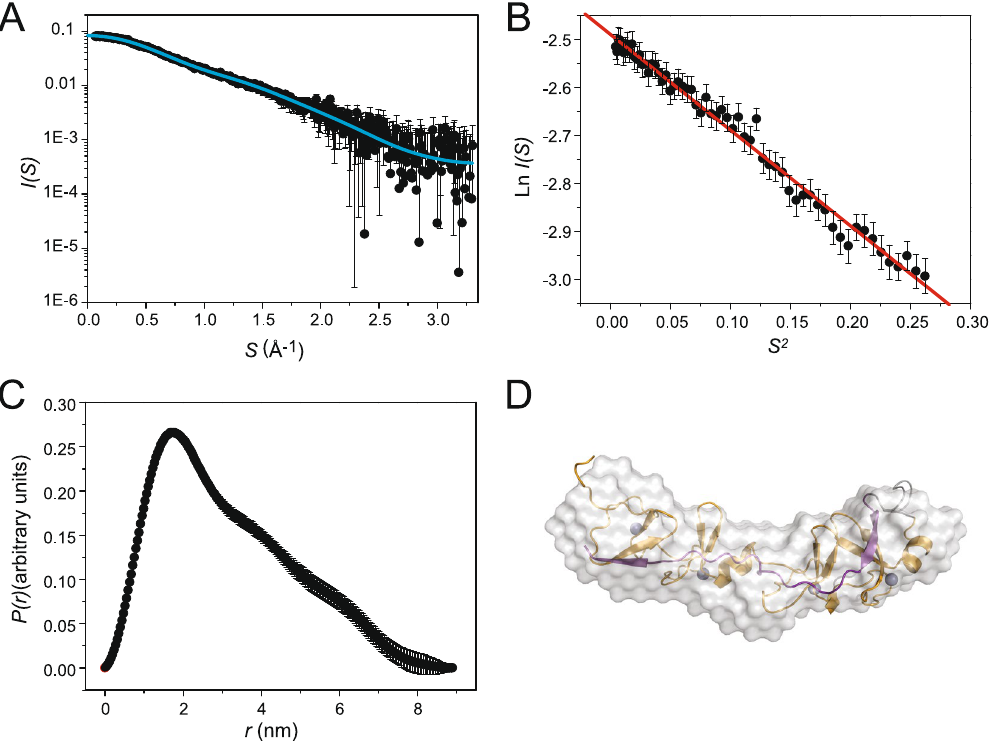
Figure 4. SAXS analysis for CEH-14–LIM-7. ( A ) Buffer-corrected, desmeared SAXS scattering curve of CEH- 14–LIM-7 (circles; 5.2 mg mL − 1 ) in 20 mM Tris pH 8.0, 150 mM NaCl, 1 mM TCEP, overlaid with the theoretical scattering profiles of an homology model of CEH-14–LIM-7 based on the template of the LHX3-ISL1 crystal structure (1RGT Chain B; cyan line) calculated by CRYSOL. ( B ) Guinier plot showing linearity of low Q data. ( C ) The pairwise distribution P ( r ) profile. ( D ) Shape restoration model of CEH-14–LIM-7 (white surface) superimposed with an homology model based on the template of the LHX3-ISL1 crystal structure (orange and purple; zinc ions are shown as grey